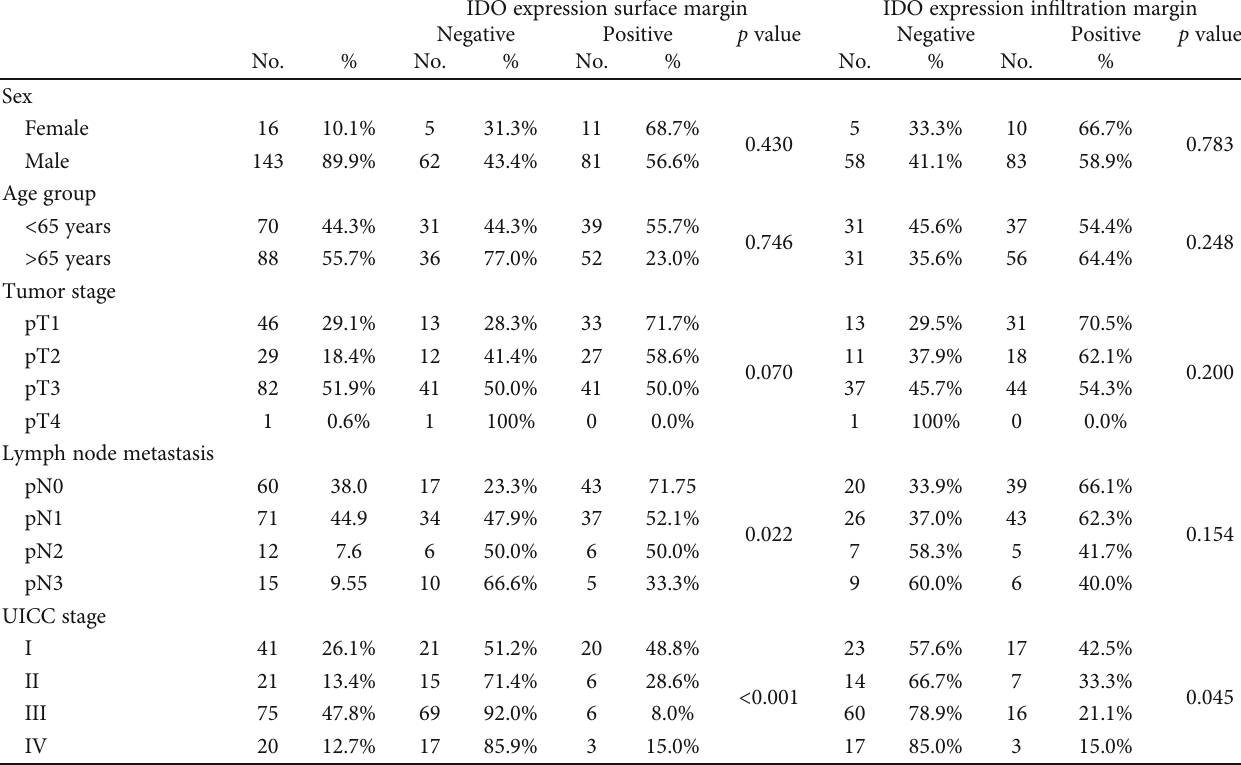
Table 1: Patient characteristics and IDO expression results on the test cohort ( n = 165 ; 159